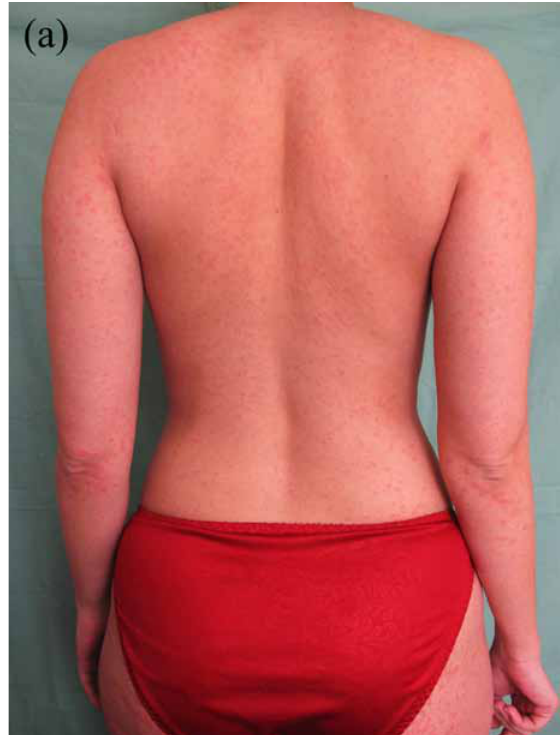
Figure 2a. Generalized papular CADR – back of the patient No. 21 Figure 2b. Generalized papular CADR – thigh of the patient No.